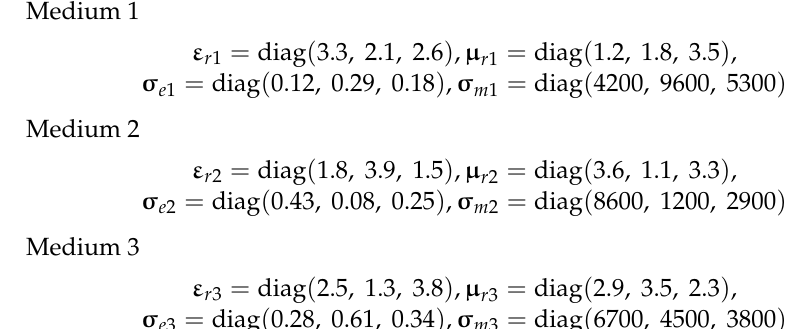
( c ) Figure 8. Time ‐ domain results of observation point E (0,0,0) when waves propagate through the multi ‐ layer spheres: ( a ) E x ; ( b ) E y ; ( c ) E z . 0